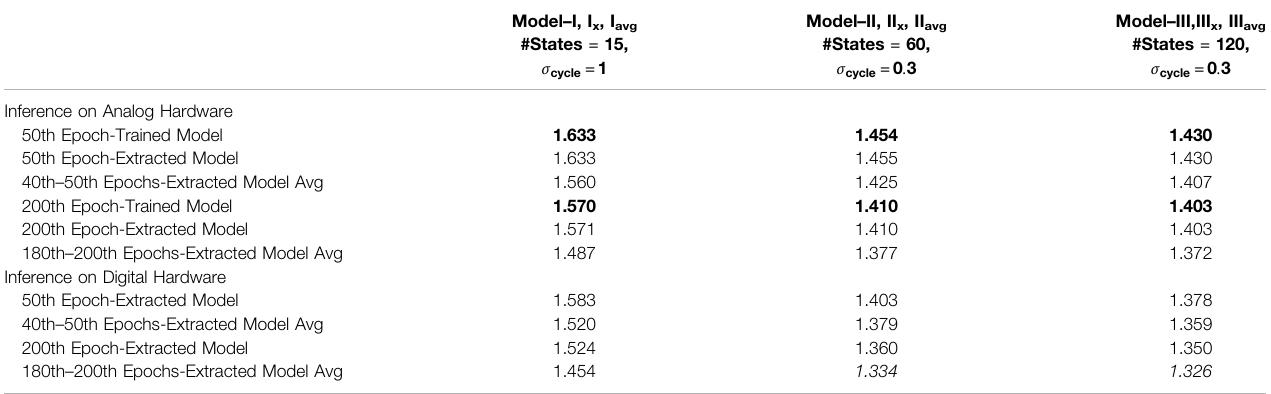
TABLE 1 | Inference results of various models on different